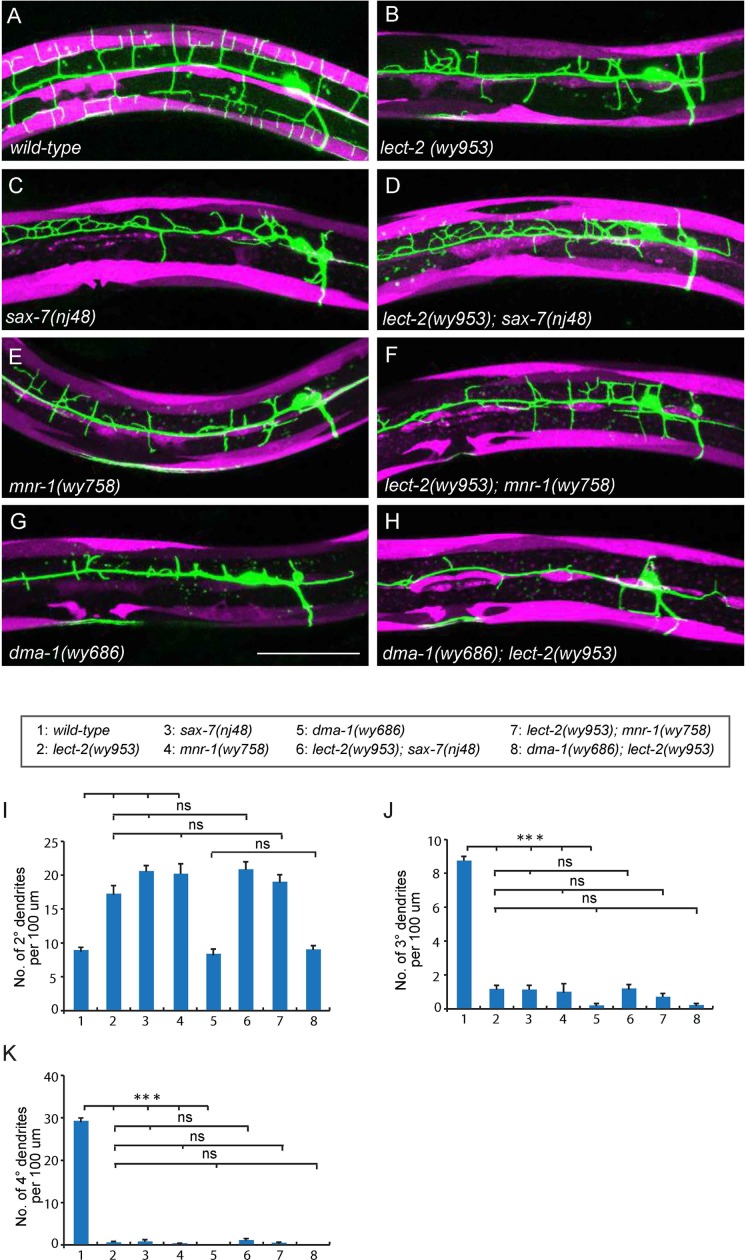
lect-2 functions in the same genetic pathway as sax-7, mnr-1 and dma-1.(A–H) Confocal images showing PVD dendritic arbors, body wall muscles and seam cells in (A) wild-type; (B) lect-2(wy953); (C) sax-7(nj48); (D) lect-2(wy953); sax-7(nj48); (E) mnr-1(wy758); (F) lect-2(wy953); mnr-1(wy758); (G) dma-1(wy686) and (H) dma-1(wy686); lect-2(wy953) mutants. Scale bar: 50 μm. (I–K) Quantifications of (I) number of 2° dendrites; (J) number of 3° dendrites; (K) number of 4° dendrites in a 100 μm region anterior to the cell body of PVD neurons. One way ANOVA with the Tukey correction was used for statistical analysis. ***p<0.0001. ns: not significant. Data are represented as mean ± SEM. 16 animals were quantified for each genotype, except for lect-2; sax-7 (13 animals were quantified).